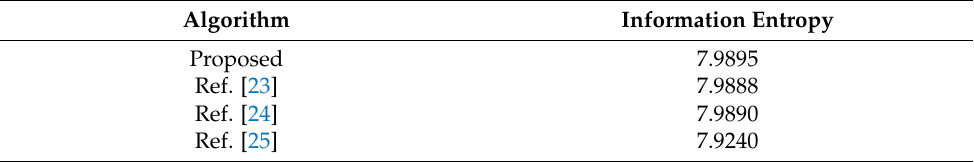
Table 3. Comparison of gray images.